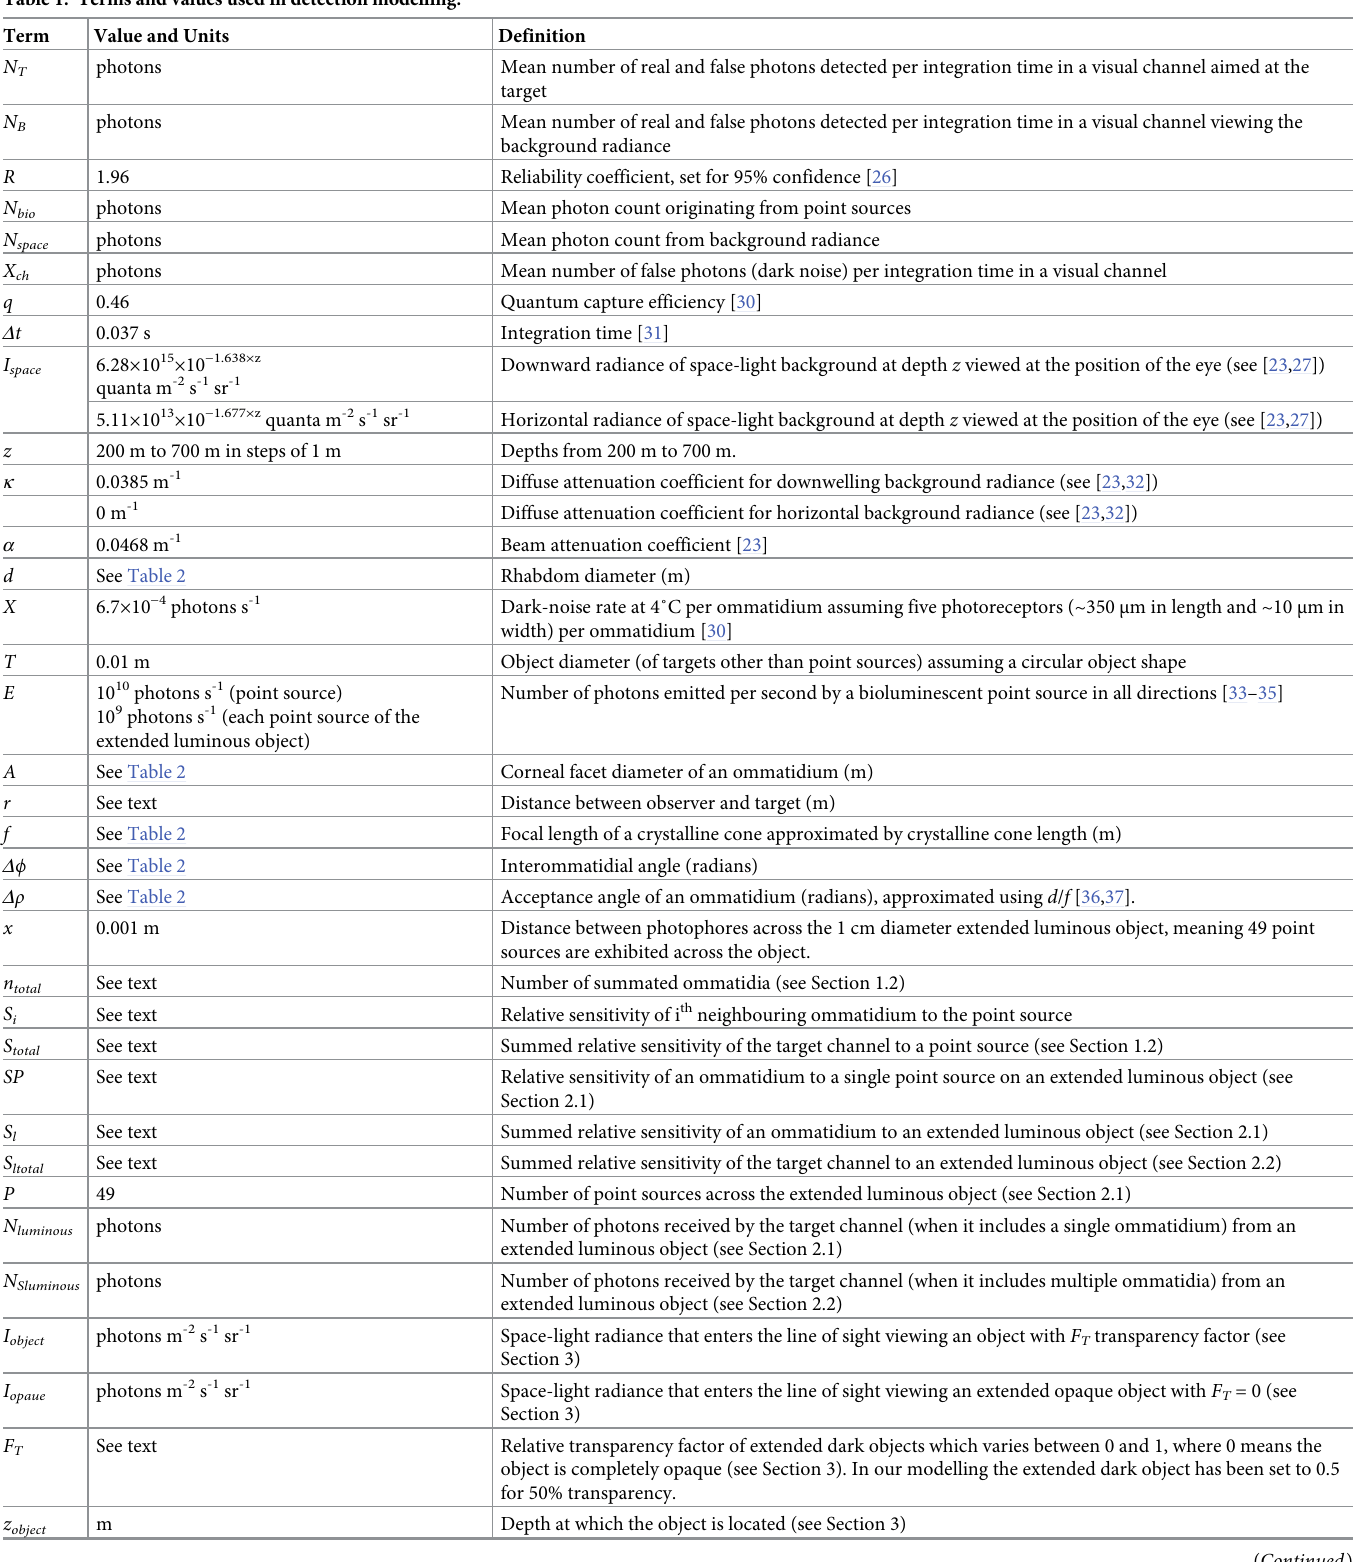
Table 1. Terms and values used in detection